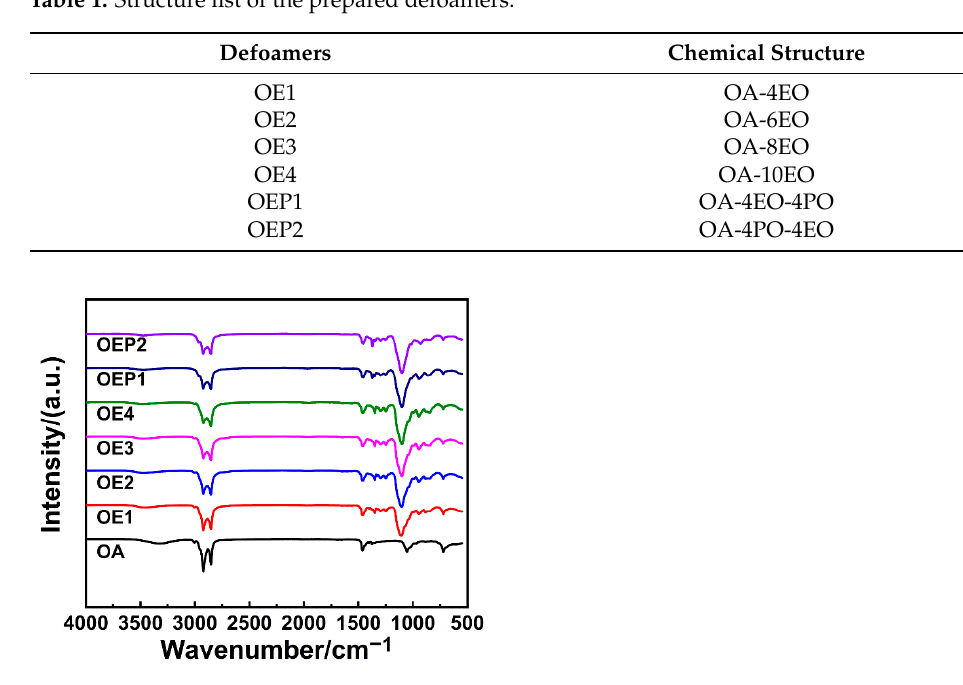
Figure 2. FT-IR spectra of the prepared defoamers.